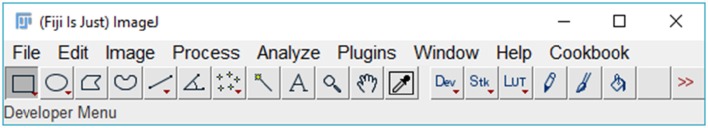
Main menu of Fiji software.